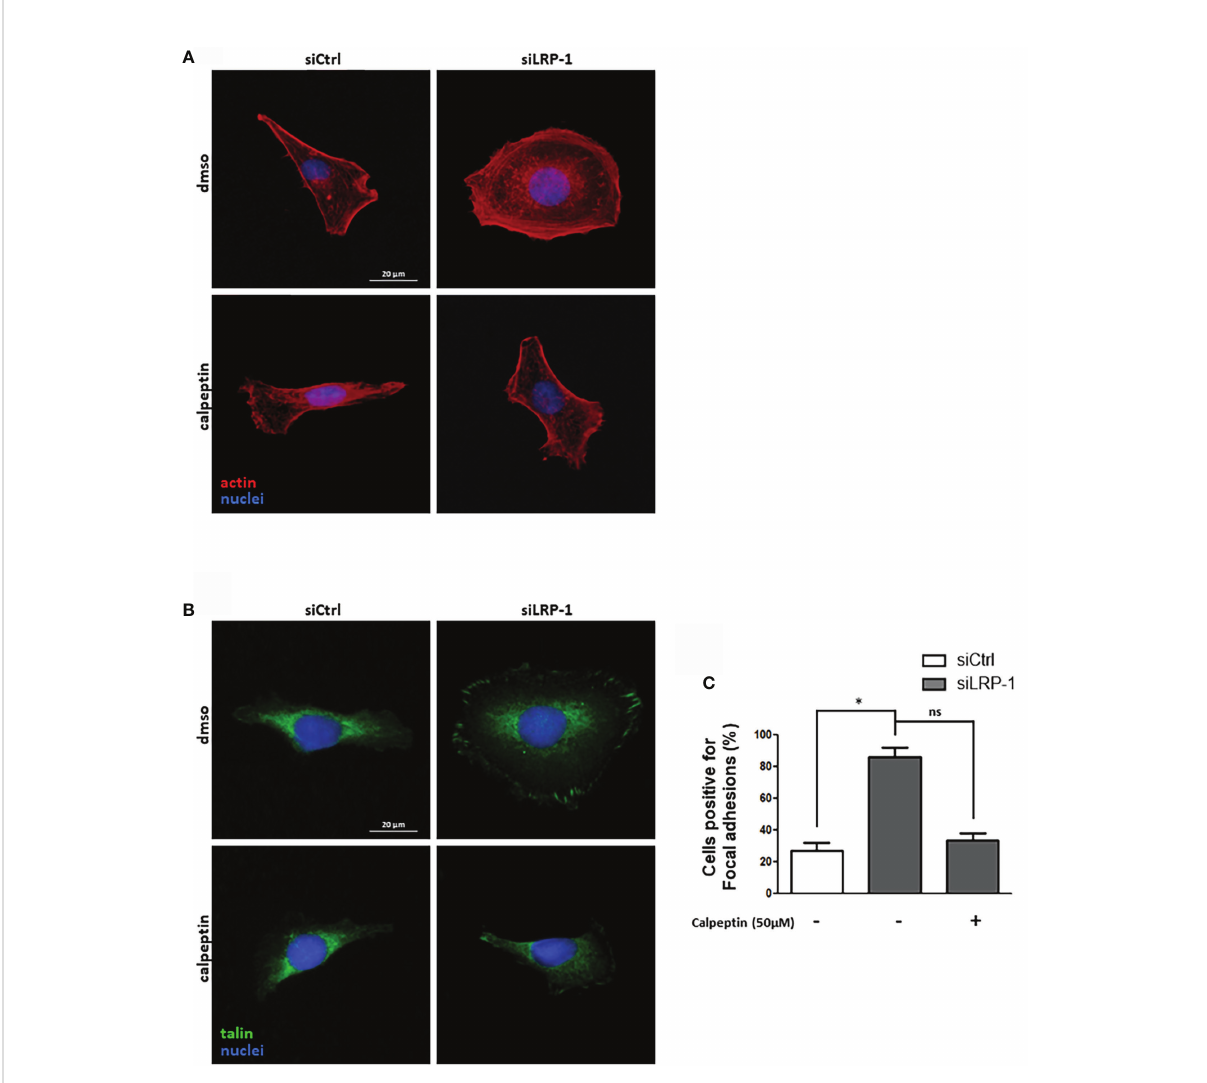
FIGURE 6 LRP-1-mediated control of calpain activity fi ne-tunes spreading and focal adhesion maturation in carcinoma cells. FTC133 cells transfected with siRNA sequences were cultivated two hours on gelatin-coated coverslips in the presence or absence of 50µM of calpeptin, fi xed, and labelled with phalloidin to analyze their morphology and fi brillar actin network (red) by fl uorescence microscopy. Nuclei were counterstained with DAPI (blue) (A) . Alternatively, cells were immunostained with an antibody against talin (green) to analyze the formation of focal adhesion (B) . The percentage of cells positive for focal adhesions was quanti fi ed following the inhibition of calpain activity by calpeptin or control treatment (C) . For each condition, at least one hundred of cells from three separate experiments were evaluated. ns, not signi fi cant; *, P <